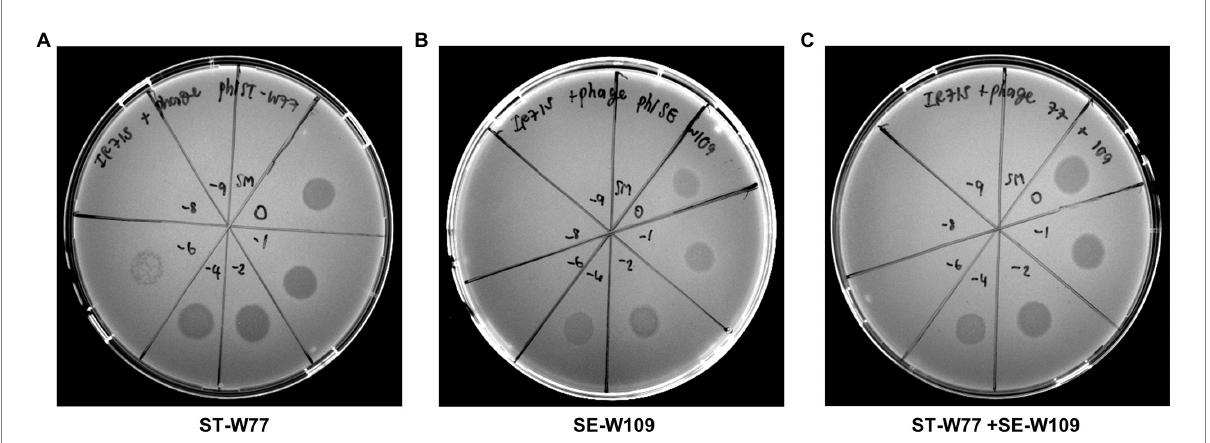
FIGURE 1 Susceptibility of S. Tm IR715 against phages ST-W77 and SE-W109. 10 μ l of different phage dilutions in SM buffer (undiluted (10 − 0 ), 10 − 2 , 10 − 4 , 10 − 6 , 10 − 8 , and 10 − 9 ) were spotted on the S. Tm lawn, and clear zones were observed at 18 h after the incubation at 37 ° C. ST-W77 (A) , SE-W109 (B) , and a